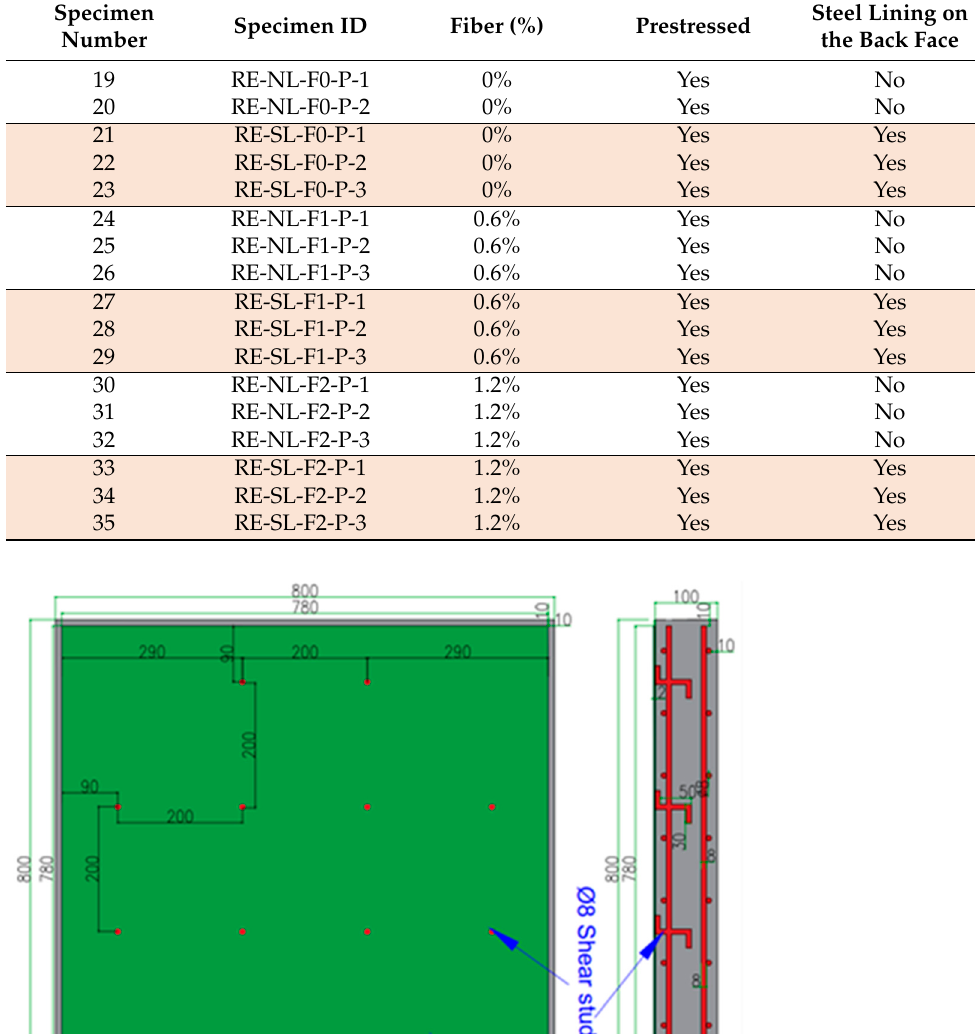
Figure 2. ( a ) Gas gun for projectile impact testing of targets; ( b ) Steel projectile with a hemispherical nose, 40 mm in diameter and 100 mm in height.